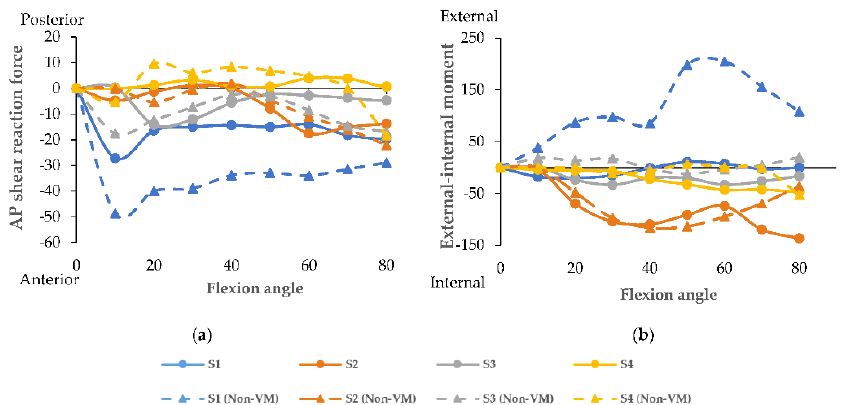
Figure A1. Knee-joint reaction forces and moments in each knee joint that underwent TKA with/without VM impairment (Sn: specimen number, non–VM: with VM impairment) during knee–joint flexion: ( a ) anterior–posterior reaction force (Fx); ( b ) internal–external moment